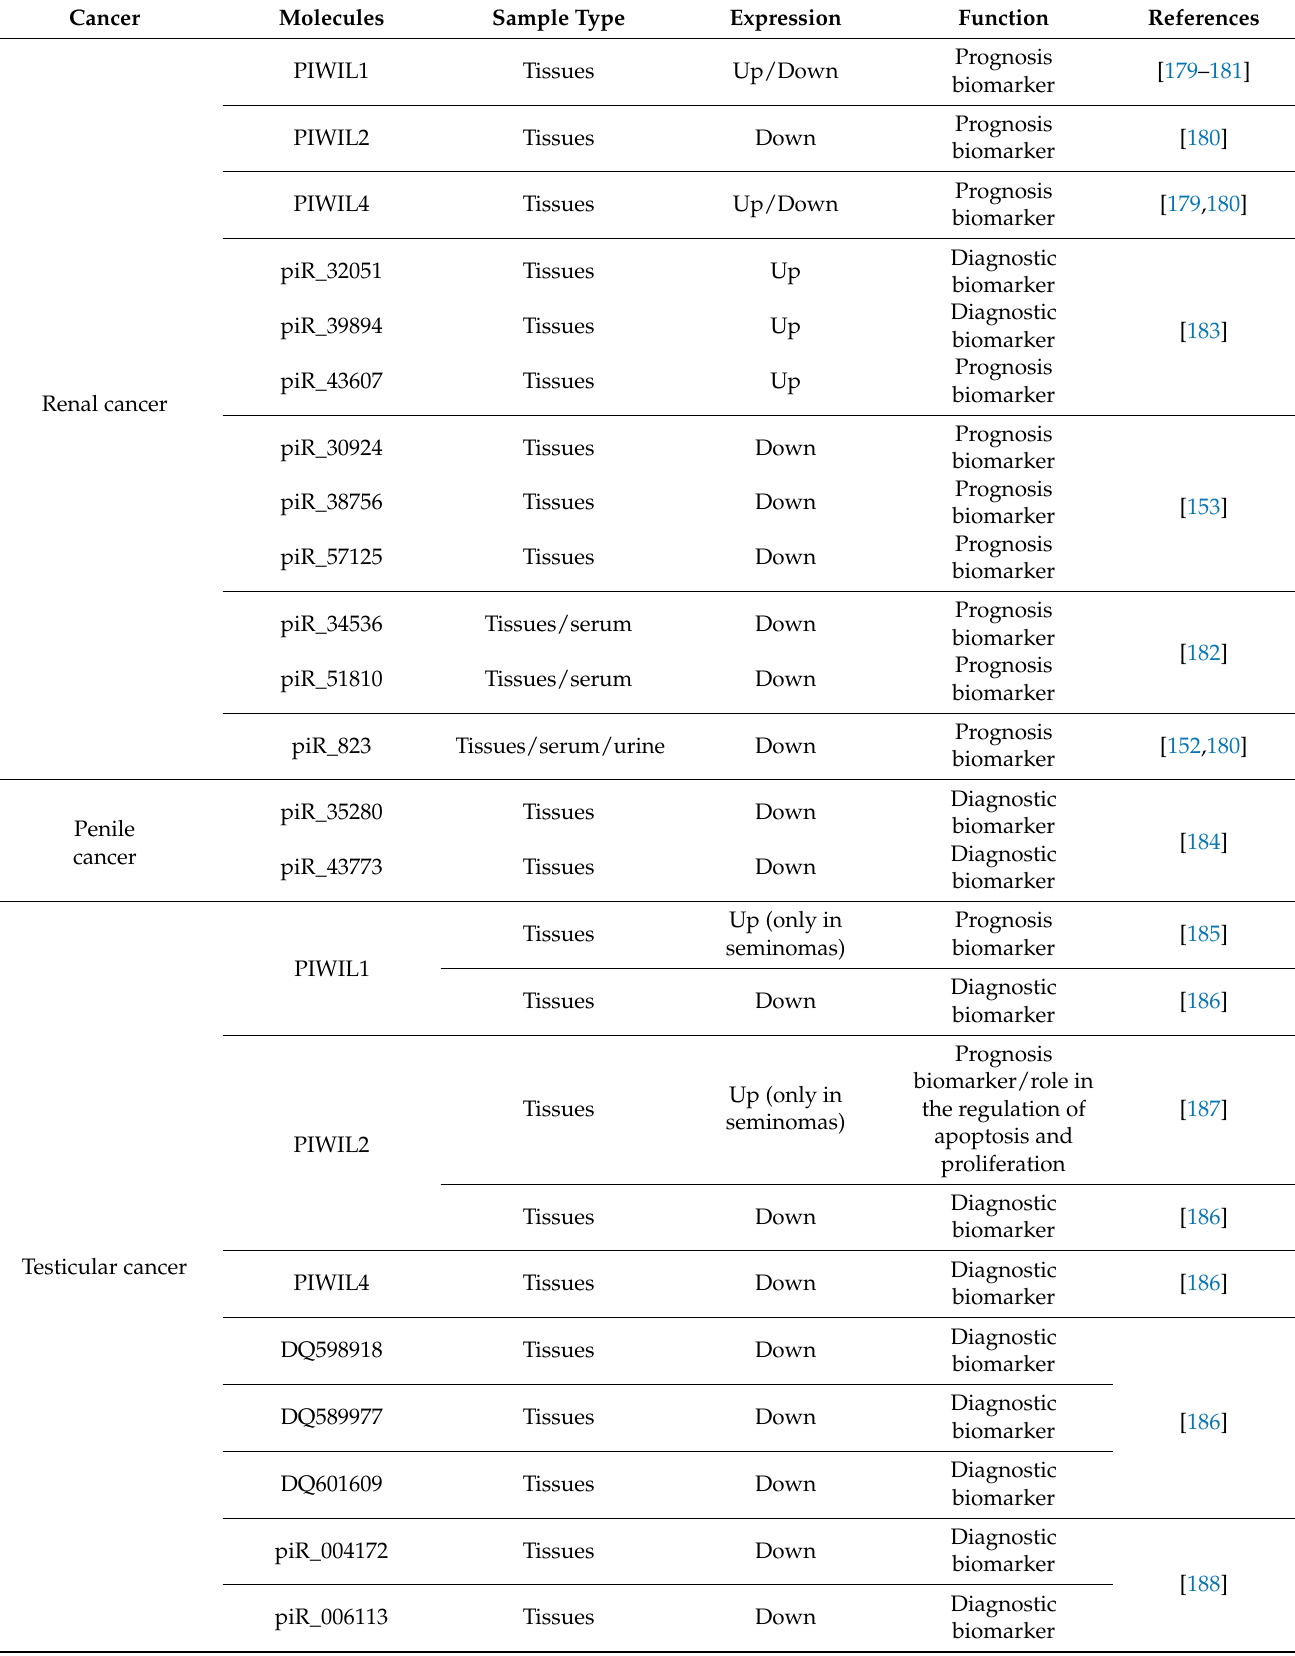
Table 3. Disturbances of piRNAs and PIWIL expression in genitourinary